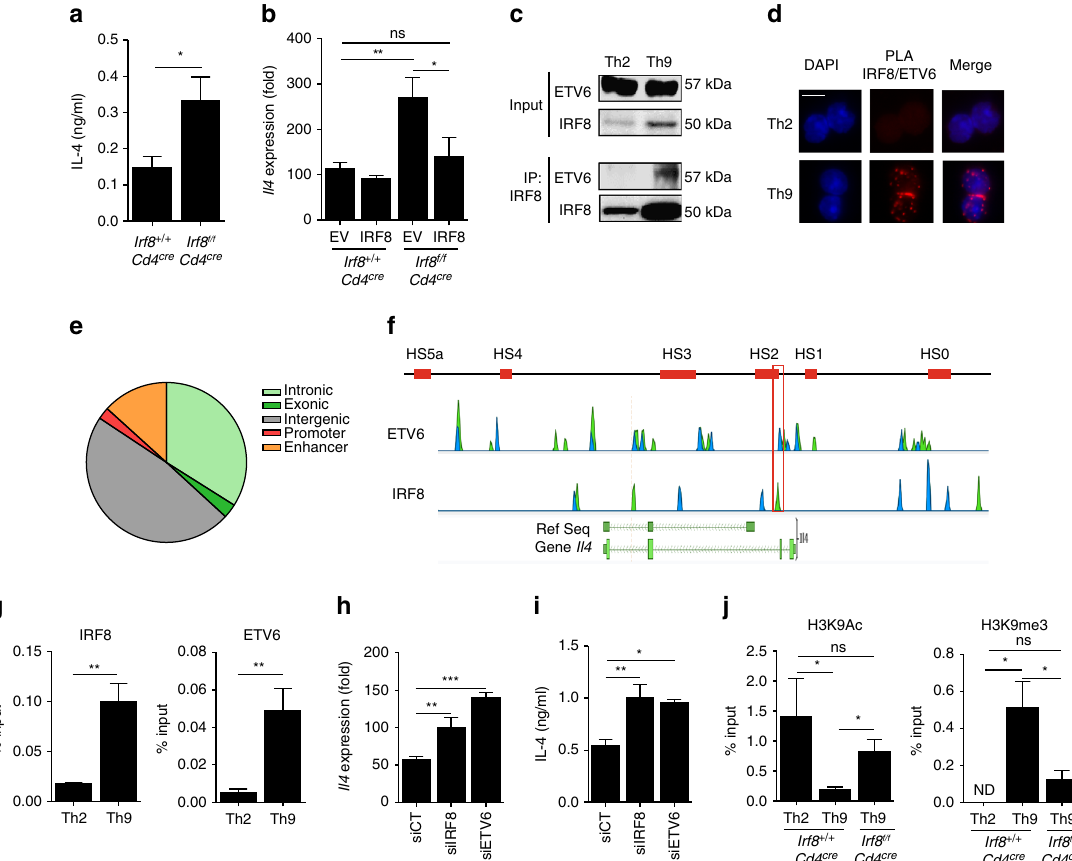
Fig. 5 IRF8 is essential for Il4 repression in Th9 cells by epigenetic mechanisms. a Irf8 + / + Cd4 cre or Irf8 f/f Cd4 cre T cells were differentiated into Th9 for 3 days. IL-4 protein release was assessed by ELISA. b WT and Irf8 f/f Cd4 cre naive CD4 + T cells were retroviral infected with an empty-GFP vector (EV) or IRF8-GFP overexpressing vector (IRF8). GFP + cells were sorted 2 days after infection and differentiated for 3 days into Th9 cells. Il4 mRNA expression was analysed. c Immunoprecipitation (IP) assay using anti-IRF8 antibody on CD4 + T cells differentiated into Th2 or Th9 cells for 24 h, followed by immunoblot analysis with indicated speci fi c antibodies. Ig is used as a control. d Proximity ligation assay between IRF8 and ETV6 (red dots) in WT Th2 or Th9 cells after 24 h of differentiation. DAPI staining (blue) indicates the nucleus. Magni fi cation are ×63, scale bar represent 5 µ m. e Distribution of ETV6 ChIP sequencing peaks in WT Th9 cells. f Top panel, schematic representation of DNase I hypersensitive sites (red boxes). Bottom panel, Chip-sequencing analysis of the Il4 gene after Chip-Seq for ETV6 and IRF8 in Th9 cells differentiated for 24 h. The overlap between ETV6 and IRF8 at HS2 locus is framed in red. g ChIP assay of IRF8 (left) or ETV6 (right) to the HS2 locus of Il4 in Th2 and Th9 cells differentiated for 6d. h , i WT naive CD4 + T cells were transfected with siCT or siIRF8 or siRNA against Etv6 (siETV6), and then polarised under Th9 conditions 3d. Relative expression of Il4 mRNA ( h ) ELISA analyses of IL-4 protein in supernatant ( i ). j ChIP analysis of the binding of H3K9Ac (left) and H3K9me3 (right) at the HS2 locus of Il4 in Th2, Th9 and Th9 IRF8 − / − cells. ns, not signi fi cant; * P < 0.05, ** P < 0.01; *** P < 0.001 (Mann – Whitney test ( a , g )) or Kruskal – Wallis test ( b , h – j ). Data are from four ( g – j ) or fi ve ( a , b ) independent experiments (mean and s.e.m.)